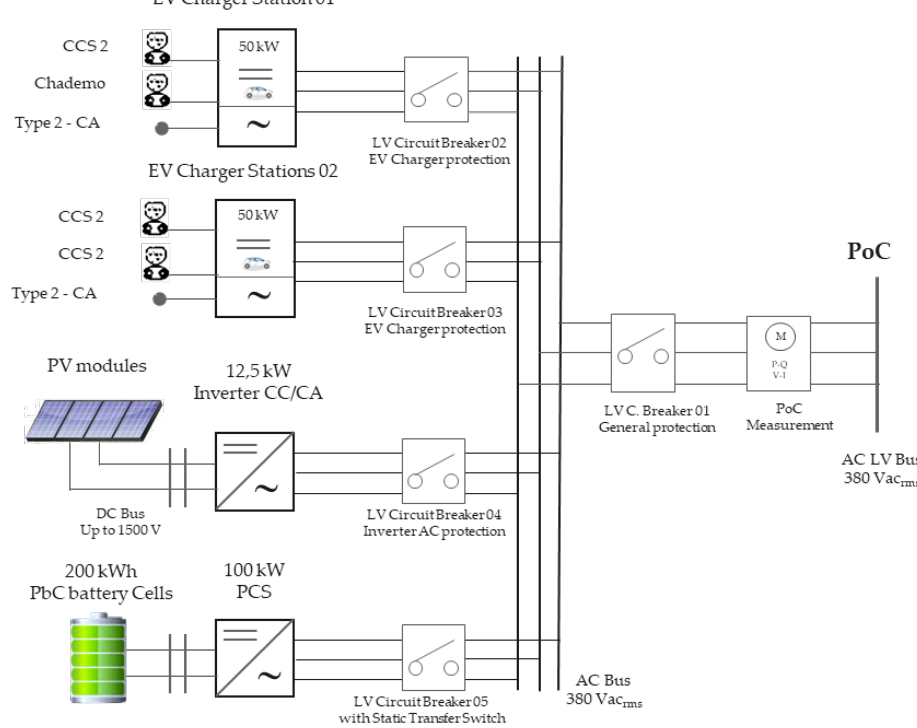
Figure 1. Fast charging stations with PV and BESS—simplified diagram.